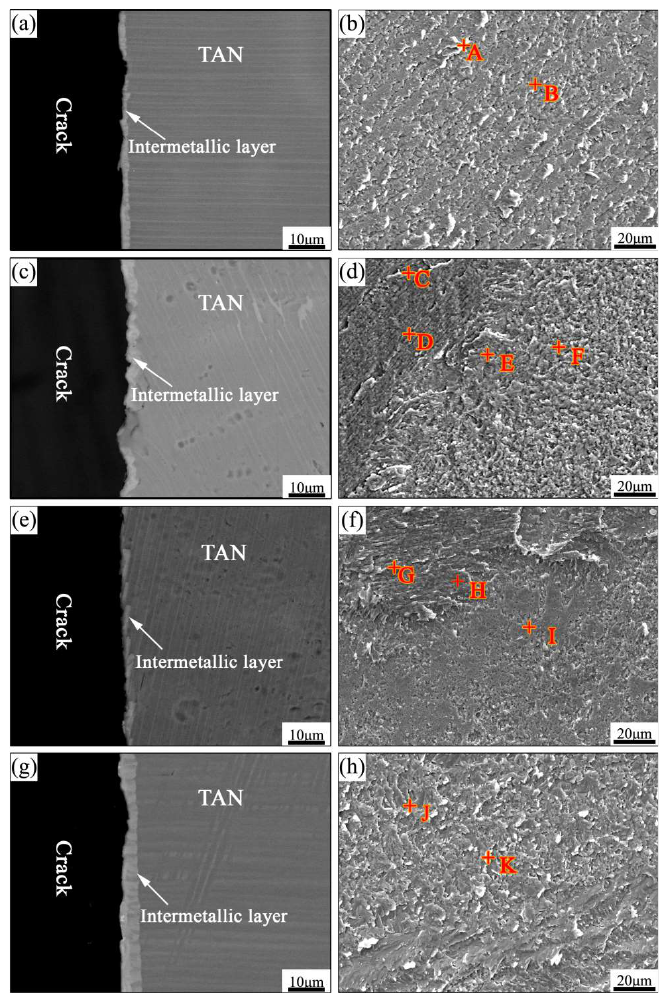
Figure 7. Fractured cross-section BSE images and fractography of the joints bonded at ( a – b ) 950 °C /60 min, ( c – d ) 970 °C /60 min, ( e – f ) 970 °C /120 min, and ( g – h ) 970 °C /150 min. (TAN side).